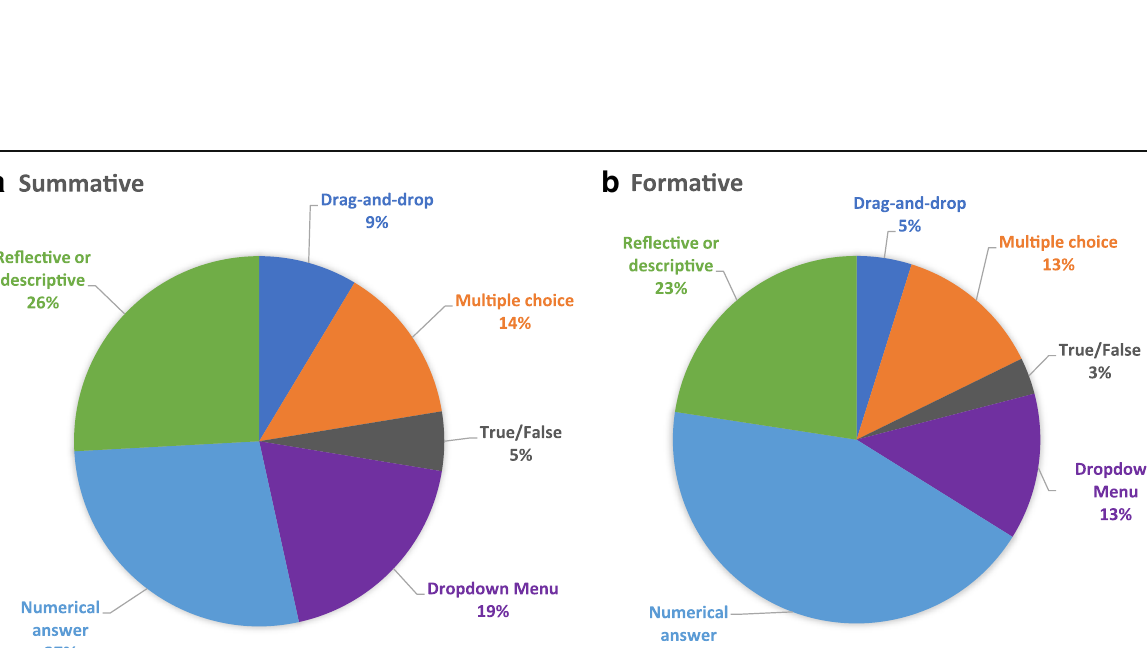
Fig. 7 a Percentages of different types of summative questions. b Percentages of different types of formative